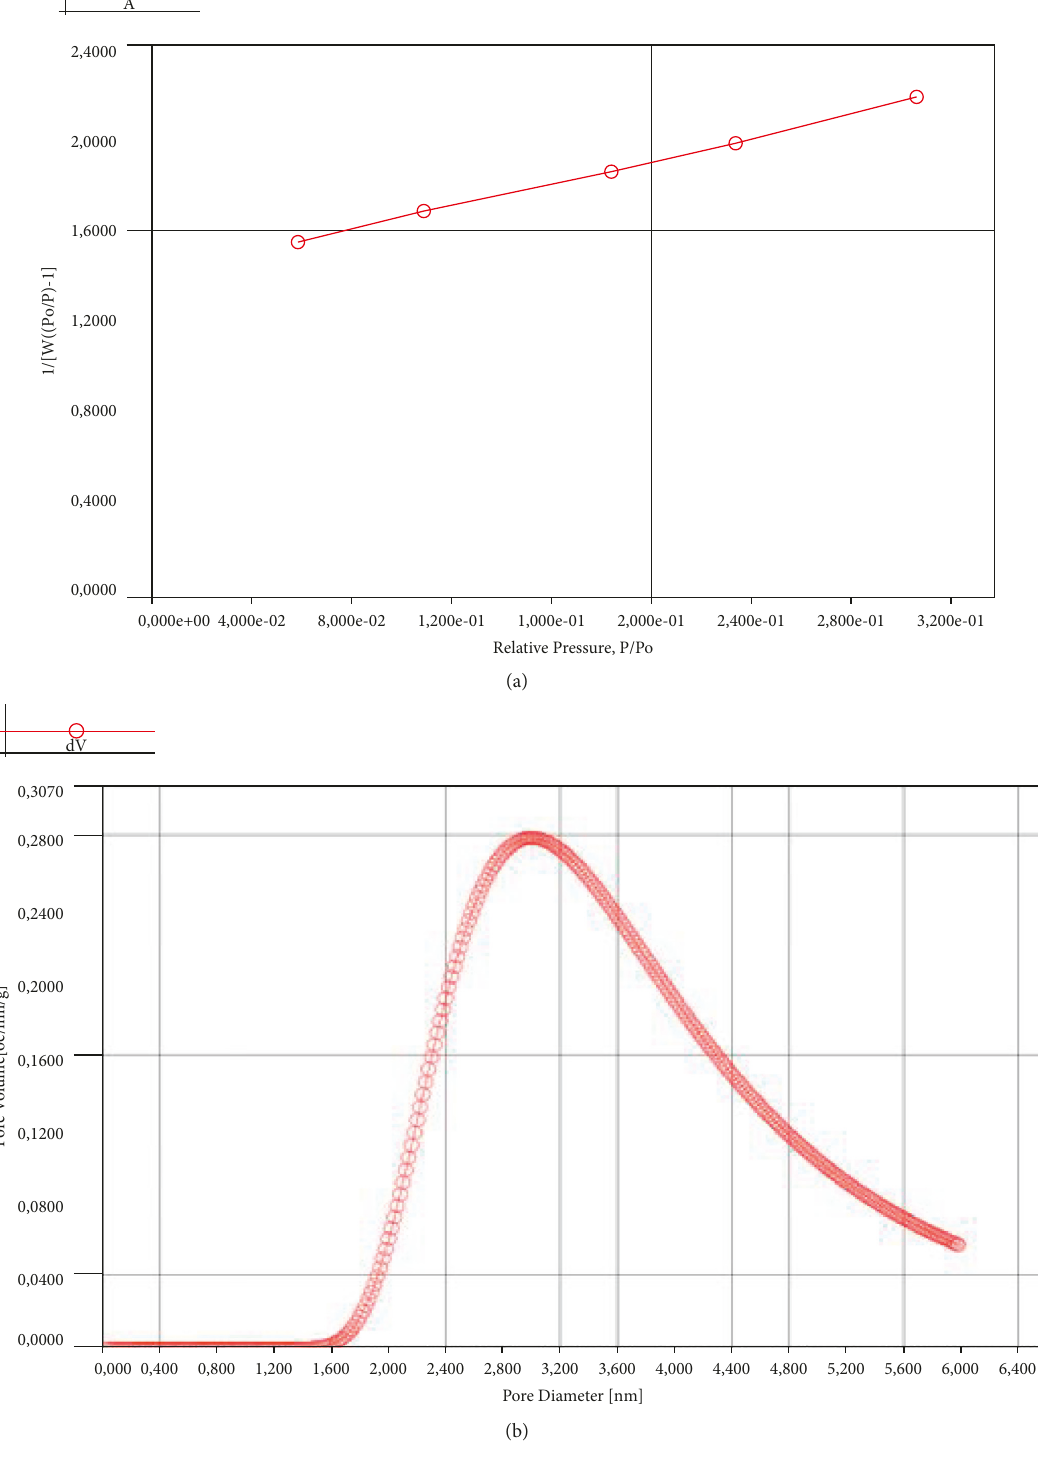
Figure 1: (a) BET surface area plot. (b) BJH desorption pore volume versus pore diameter of BAC-P adsorbent after